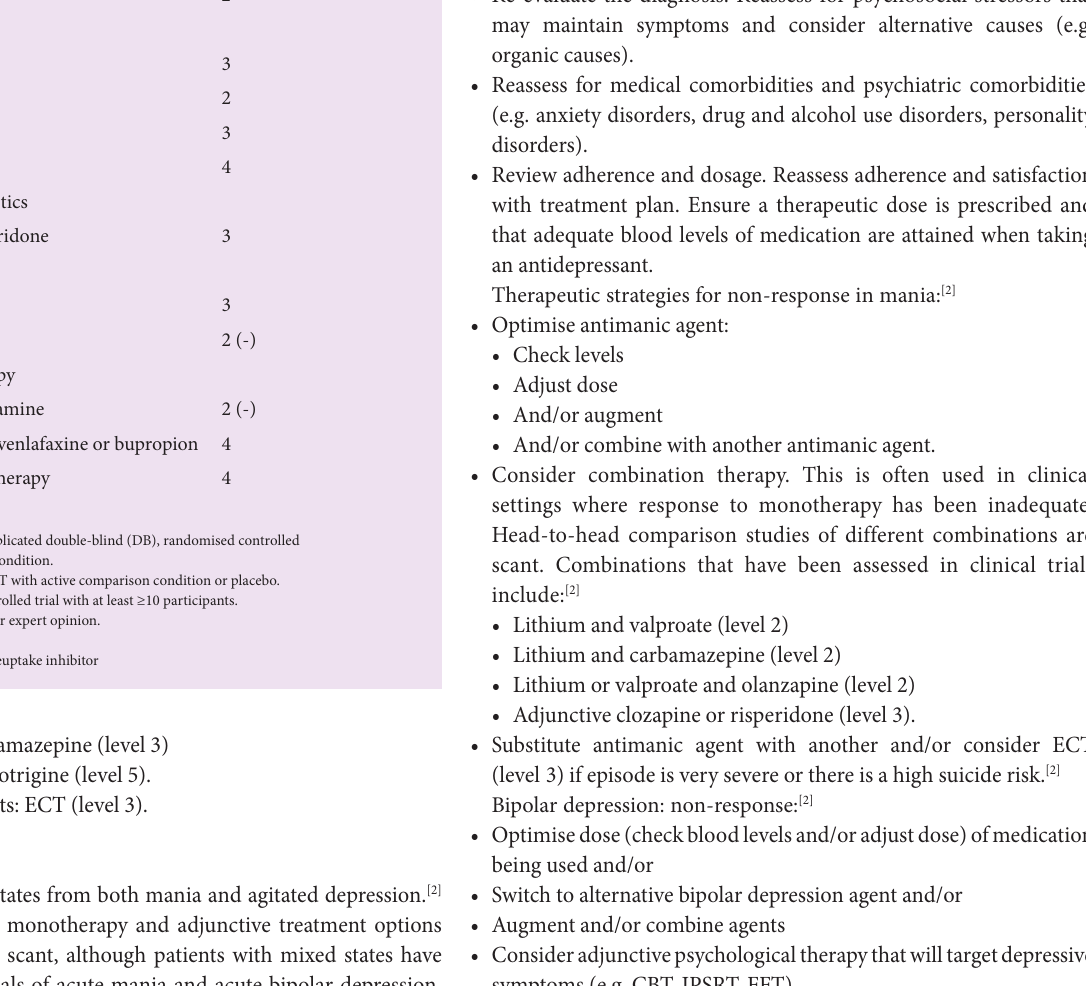
Fig. 2 outlines the treatment algorithm. Please refer to Appendix A for other aspects of treatment and management.